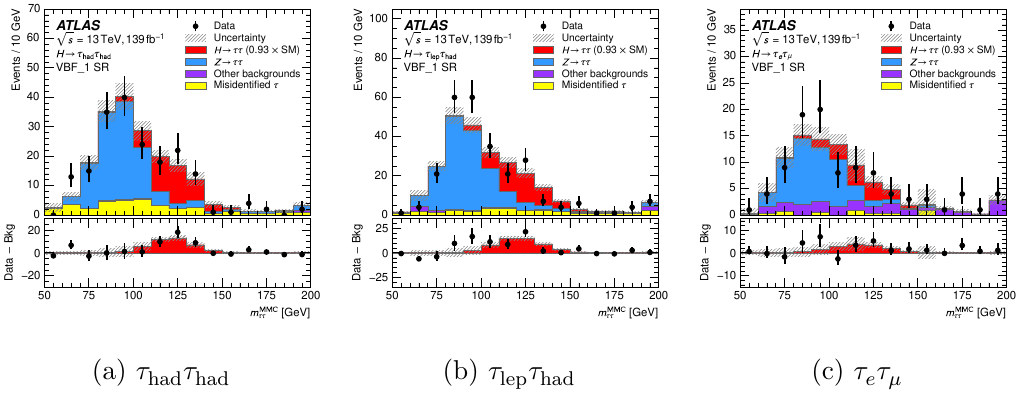
Figure 10. Distribution of the reconstructed ττ invariant mass ( m MMC ) for all events in the ττ VBF_1 categories of (a) τ τ , (b) τ τ and (c) τ τ signal regions. The bottom panel shows had had lep had e µ the differences between the numbers of observed data events and expected background events (black points). The observed Higgs boson signal, corresponding to ( σ × B ) / ( σ × B ) = 0 . 93 , is shown SM with a filled red histogram. Entries with values above the x -axis range are shown in the last bin of each distributions. The dashed band indicates the total uncertainty on the total predicted yields. The prediction for each sample is determined from the likelihood fit performed to measure the pp → H → ττ